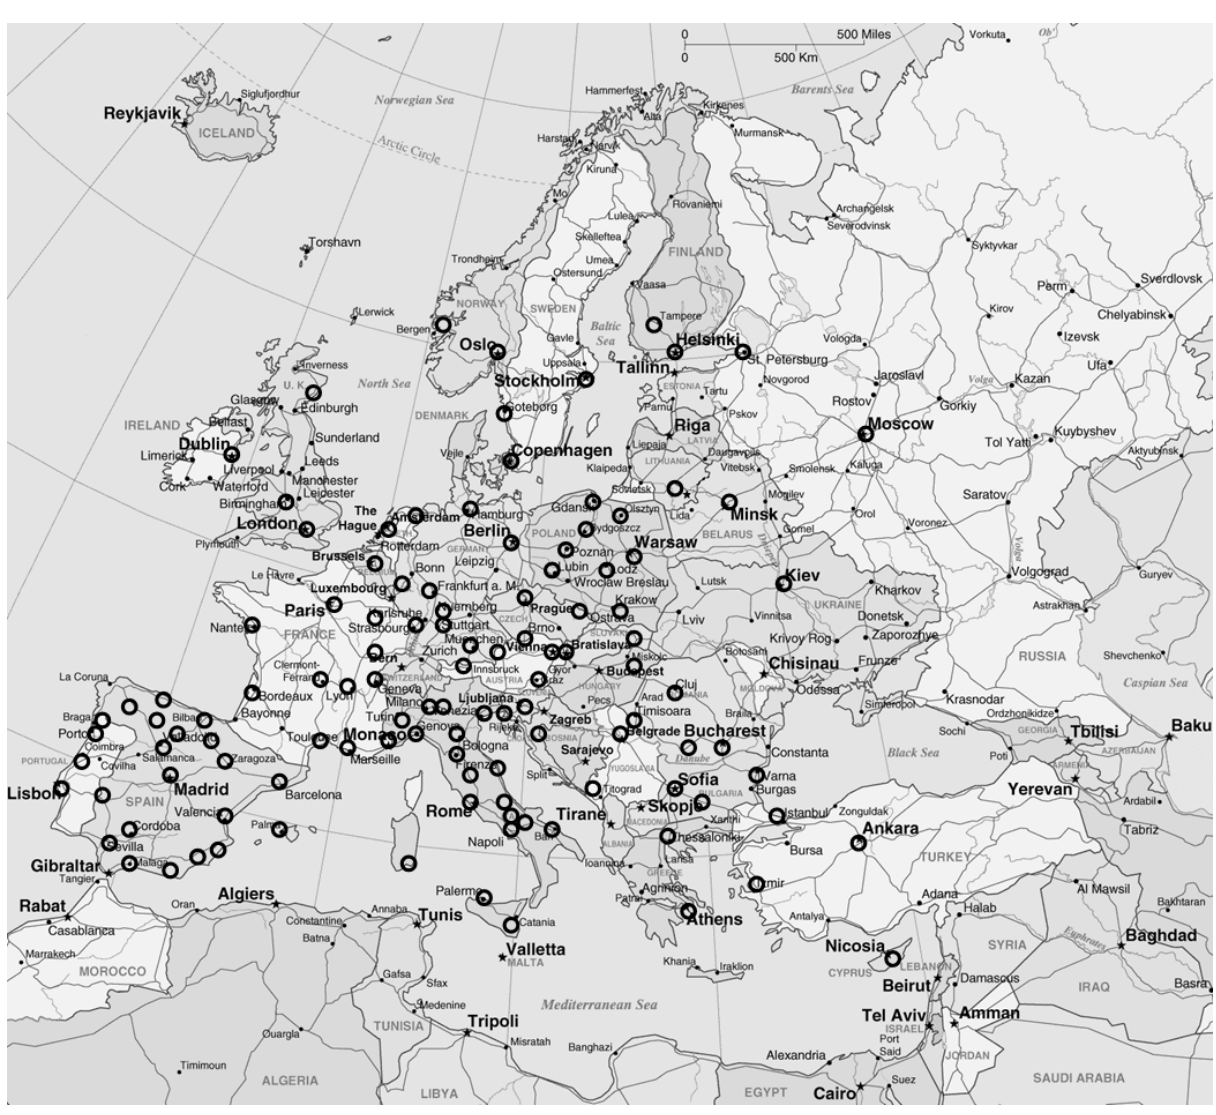
Figure 1. The geographical distribution of selected cities for establishing climatic zones in the European region. Map: European Commission (http://ec.europa.eu/avservices/), © European Union,